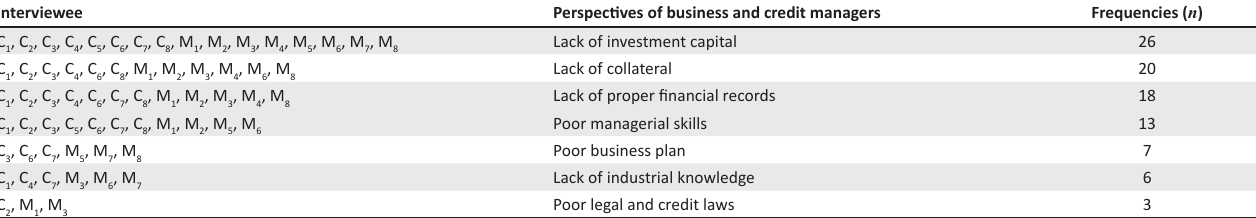
TABLE 3: Perspectives of participants with regard to challenges faced by formal financial institutions in providing credit to small and medium enterprises.